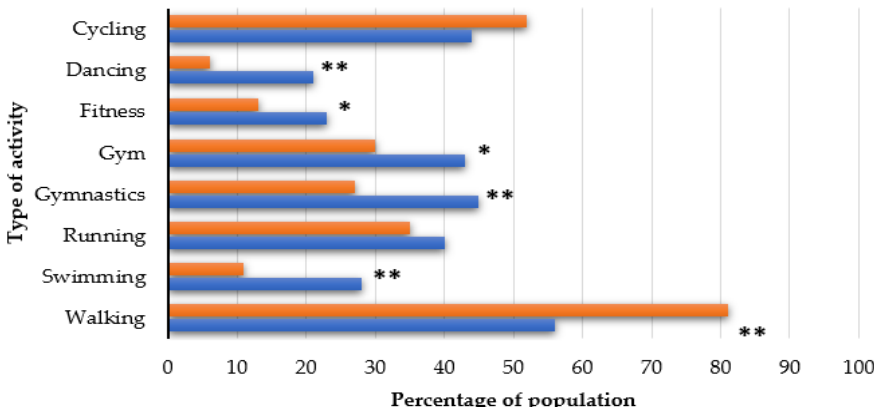
Figure 1. Di ff erences between the type of physical activity “before” and “during” the COVID-19 pandemic. Di ff erences between “before” and “during” the COVID-19 pandemic were evaluated by the Chi-square test (* p < 0.05 and ** p < 0.01).